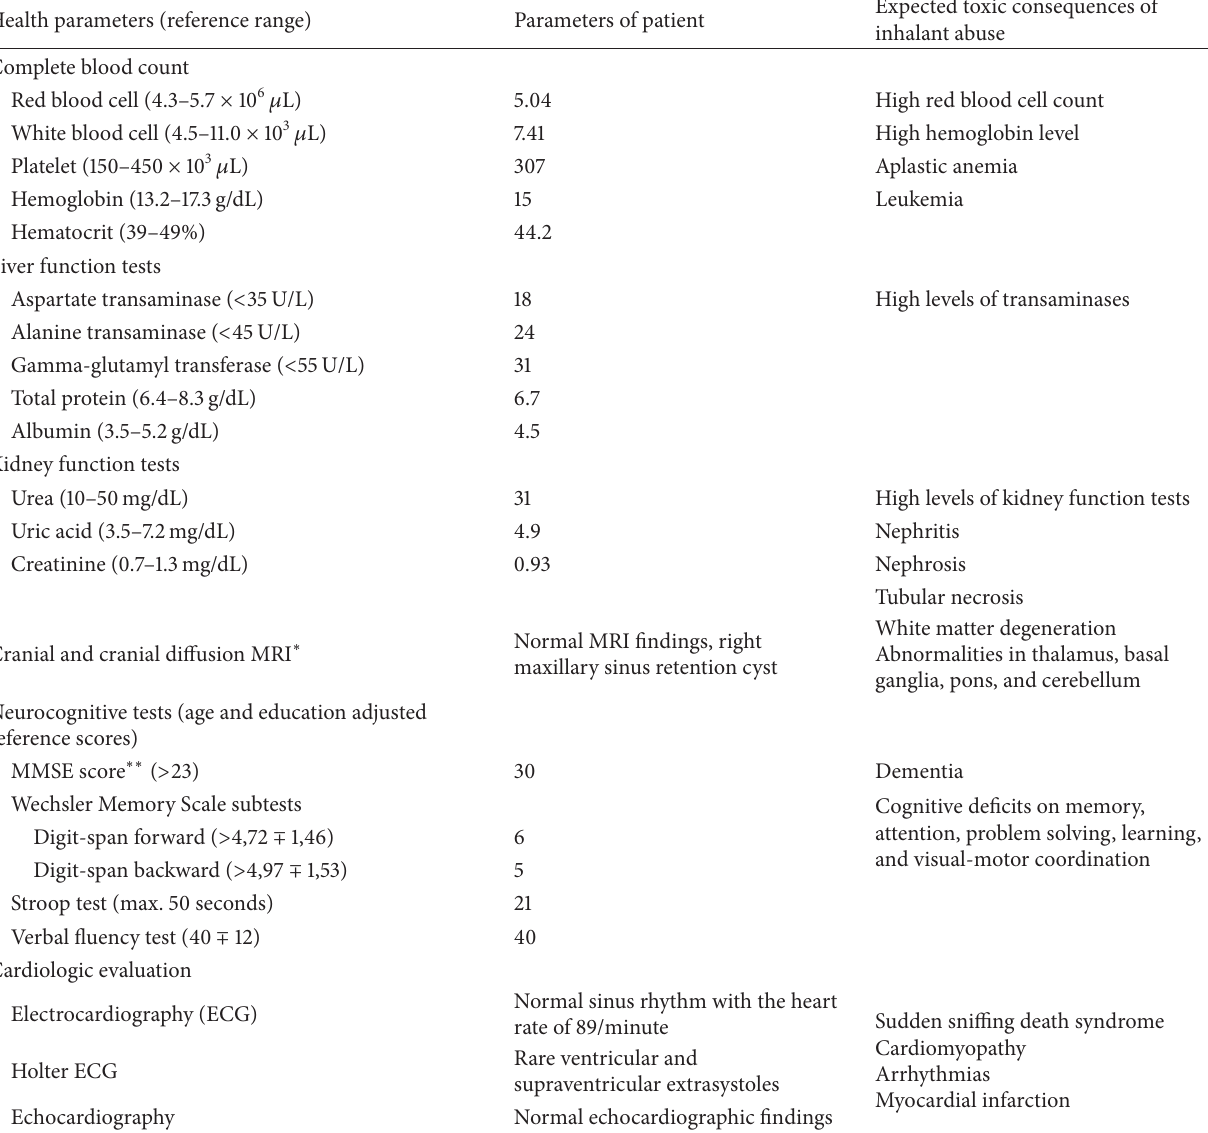
Echocardiography Normal echocardiographic findings ∗ Magnetic resonance imaging. ∗∗ Mini Mental State